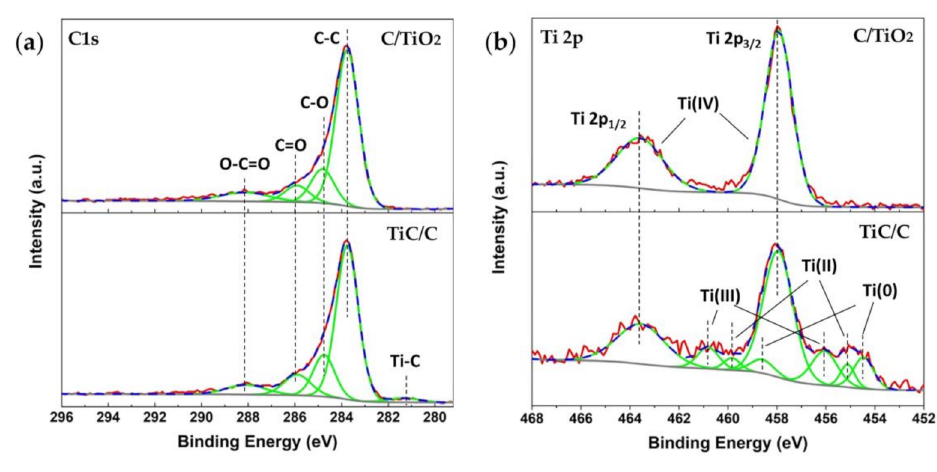
Figure 4. XPS spectra of ( a ) C / TiO 2 and ( b ) TiC / C